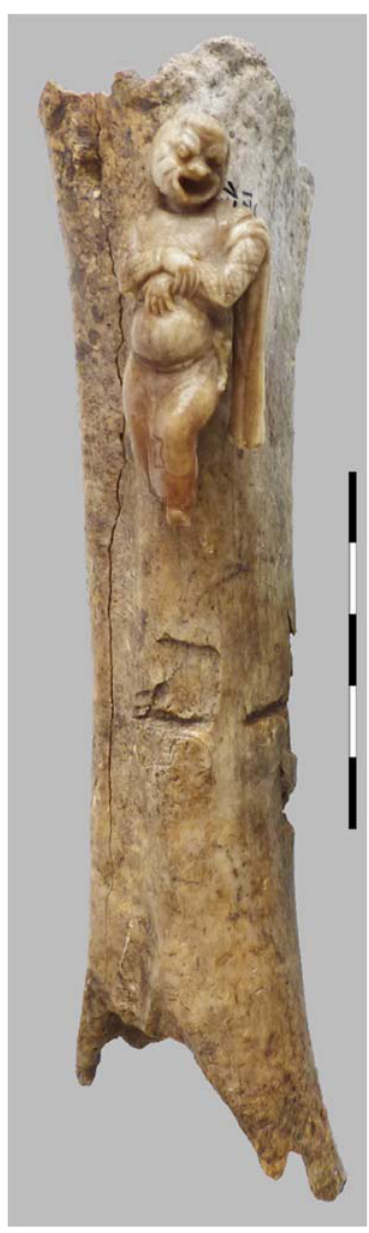
Figure 7: Proposed anatomical location of the fi gurine from I ž a - Leànyvàn on the proximal of a medial – cranial side of a right ( gnawed ) metatarsal bone from bovid sp. also found on the same archaeological site. Scale subdivision, in centimetres ( Photo: Éva David )